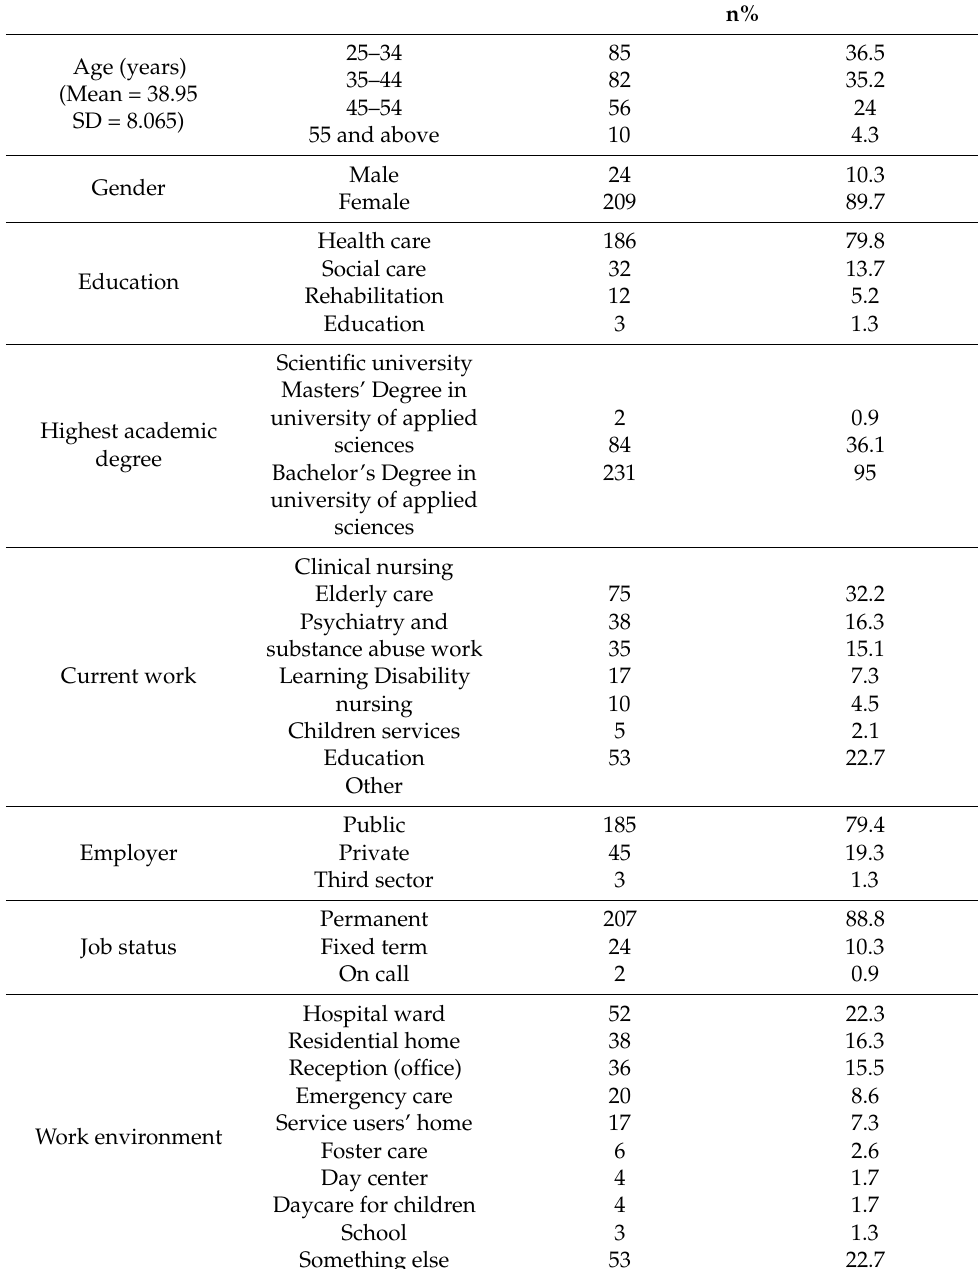
Table 4. Characteristics of the sample (n =